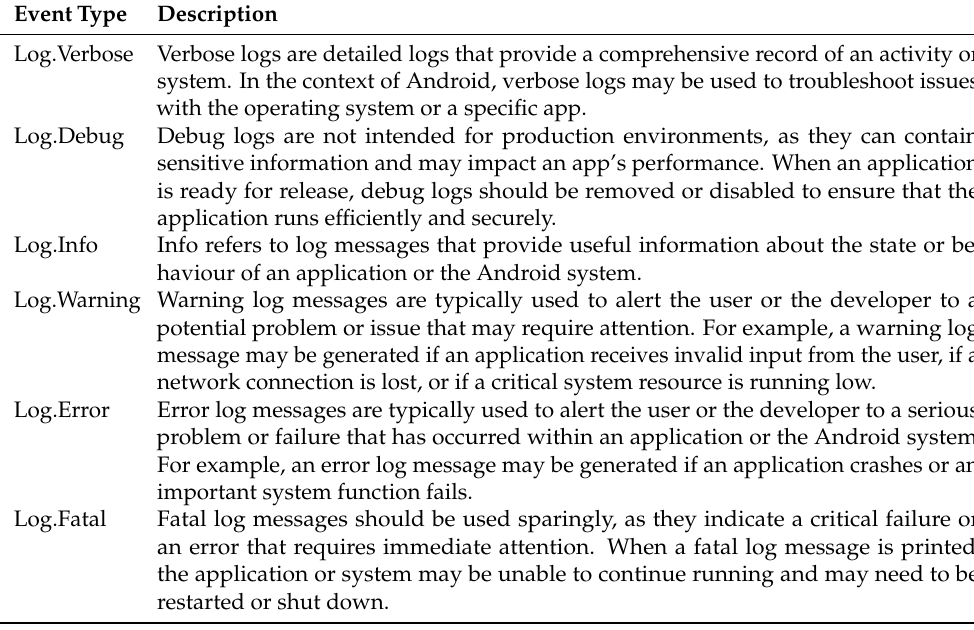
Table 2. Logcat event